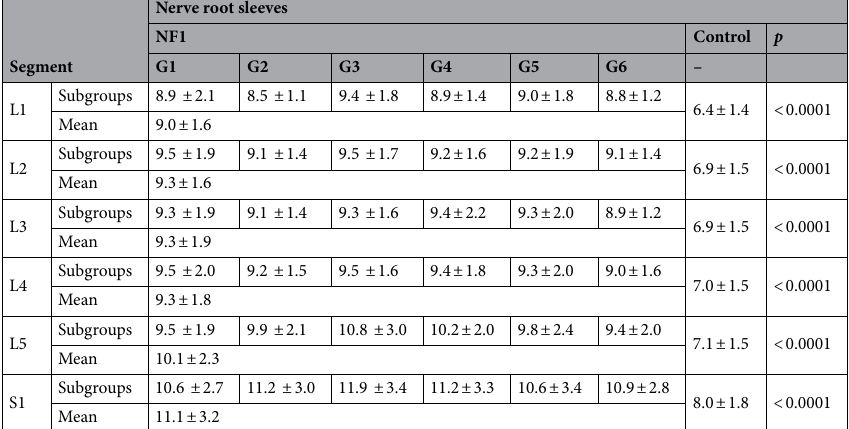
showed a higher prevalence in the NF1 group than in the control group (Table 1). The most common spinal abnormalities identified in NF1 patients were dural ectasia (Oost) (NF1: 85.5% vs. control: 61.8%) and dural ectasia (Ahn) (NF1: 44.7% vs. control 23.3%), scoliosis (NF1: 46.9% vs. control: 5%), and neuroforaminal tumors (NF1: 39.6% vs. control: 0%). The most common spinal deformity identified in the control group was dural ectasia (Oost) (61.8%) and dural ectasia (Ahn) (23.3%), similar to the NF1 group. The third most common spinal deformity in the control group was herniation of the intervertebral discs (NF1: 27.6% vs. control: 23.7%). Additional prevalences are given in Table 1. The most common location of meningoceles in NF1 patients was the thoracic spine with 8/14 (80%) patients affected, compared to cervical (1/14; 7.1%), lumbar (4/14; 28.6%) and sacral (1/14; 7.1%) meningoceles. Nerve root sleeves were significantly enlarged in NF1 patients compared to the control group with mean values of L1-S1 ranging from 9.0 to 11.1 mm in the NF1 group and from 6.4 to 8.0 mm in the control group (Table 2). Patients with neuroforaminal tumors displayed widened neuroforamina in all lumbar segments compared to patients